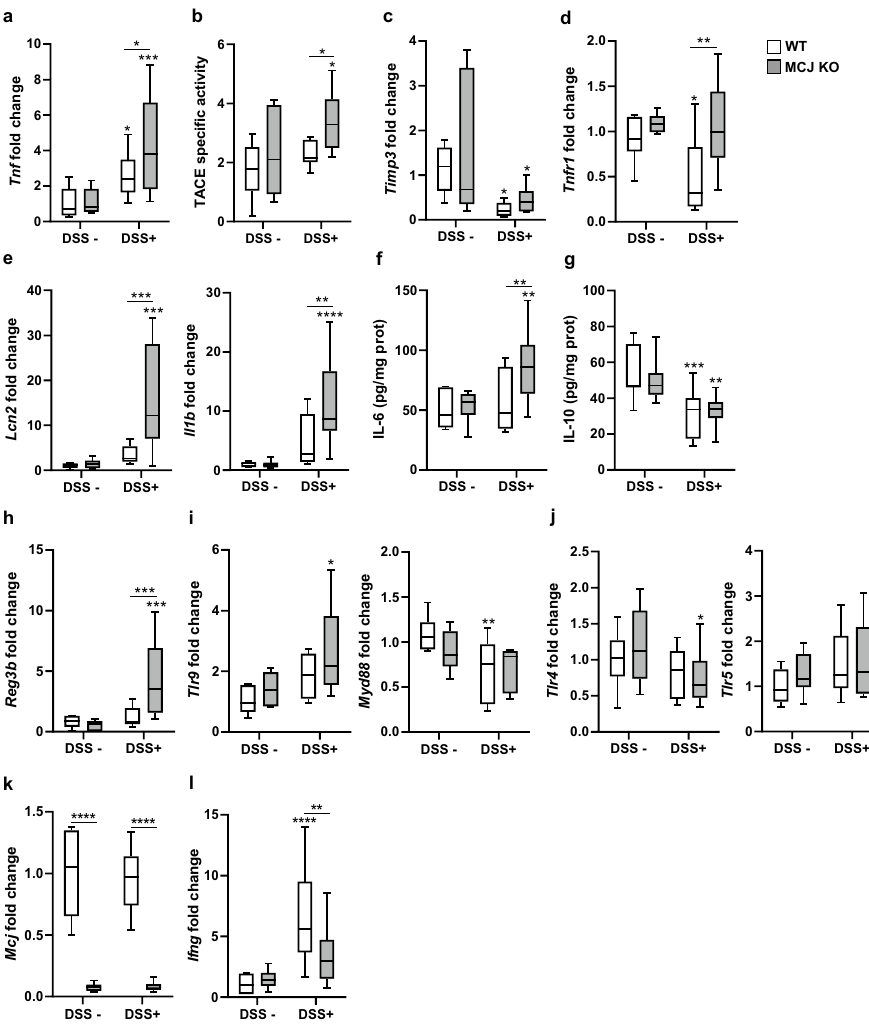
Figure 2. Evaluation of relevant genes and proteins during chronic colitis. Gene expression analysis from mice colon tissue of ( a ) Tnf , ( c ) Timp3 , ( d ) Tnfr1 , ( e ) Lcn2 and Il1b , ( h ) Reg3b , ( i ) Tlr9 and Myd88 , ( j ) Tlr4 and Tlr5 , ( k ) Mcj and ( l ) Ifng shown as mean fold change of treated experimental groups versus untreated WT group (DSS-) (n = 9 mice per group at minimum). ( b ) TACE specific activity (n = 7). ( f ) IL-6 and ( g ) IL-10 ELISA (pg/mg prot). White boxplots indicate wild-type and grey boxplots MCJ-deficient mice. Box and whisker plots of median, quartiles and range. For statistical analysis two-way ANOVA was used as applicable, * P < 0.05, ** P < 0.01, *** P < 0.001, **** P < 0.0001. “*” above boxes versus control genotype (DSS- versus DSS +), “*” above line versus different genotypes in the same experimental